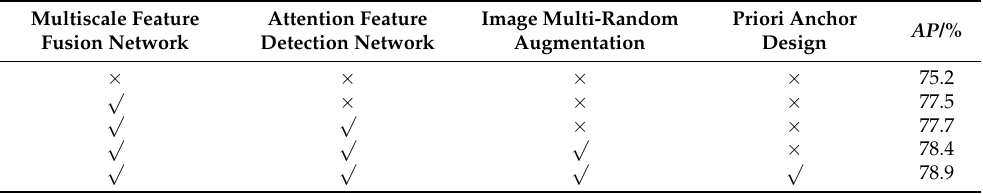
Table 4. Ablation experimental results of each module of improved